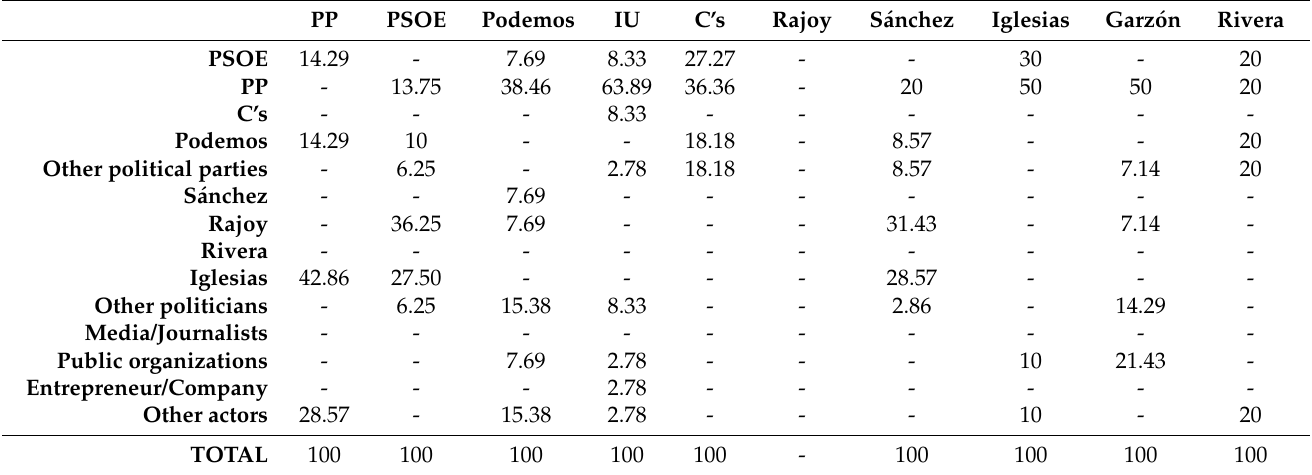
Figure 1. Presence of Criticism in the Facebook Posts of Political Actors (%). In parallel, PSOE and its candidate, Pedro S á nchez, prioritize a dynamic based on negative personalization. In this sense, both profiles put the criticisms directed at Mariano Rajoy before the Popular Party. Therefore, they place the candidate at the center of their accusations to weaken his figure and political proposals (Table 3). This practice is repeated with Pablo Iglesias, the second actor most criticized by the Socialist Party and its leader. In this case, the attacks directed at Iglesias are conditioned by the ideological position of these actors. As representatives of the left, they fight for the same voters. For this reason, the use of attacks is conveyed to differentiate themselves from rivals. Table 3. Recipients of Criticism on Facebook